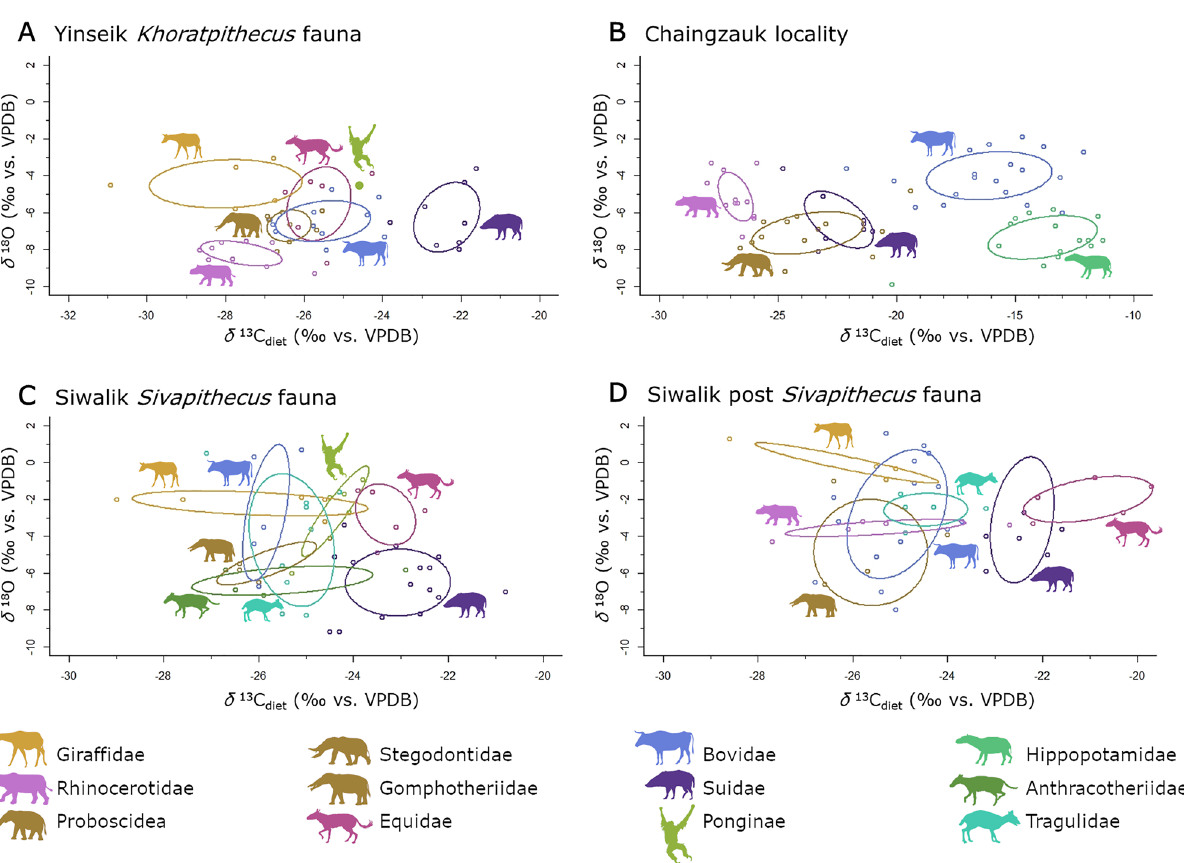
Figure 4. Bayesian niche modelling of four mammal communities. The ellipses mark the SEA (standard ellipse area) or core ecological niche, which corresponds to a 40% CI. Summary statistics are reported in Table SI 1. ( A ) Yinseik fauna including K. ayeyarwadyensis (~ 9.5 Ma), ( B ) Chaingzauk fauna (6 4 Ma) 25 , ( C ) Siwalik fauna including Sivapithecus (~ 9 Ma) 17 , ( D ) later Siwalik fauna (~ 8 Ma) 17 . Icons from PhyloPic and in public domain or under CC 3.0 license (Rhinocerotidae, Hippopotamidae, and Tragulidae by